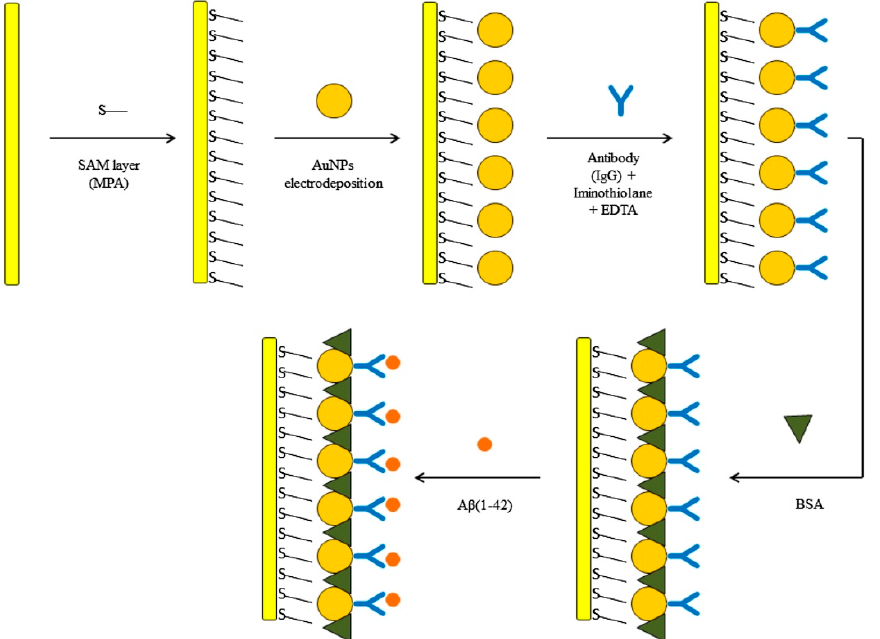
Figure 7. Schematic illustration of the electrochemical immunosensor development using a layer-by-layer approach (Reproduced with permission from [78]. Elsevier, 2017).